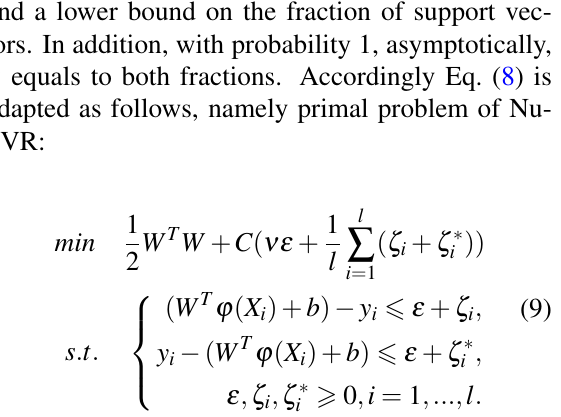
Fig. 3. Theory of slack